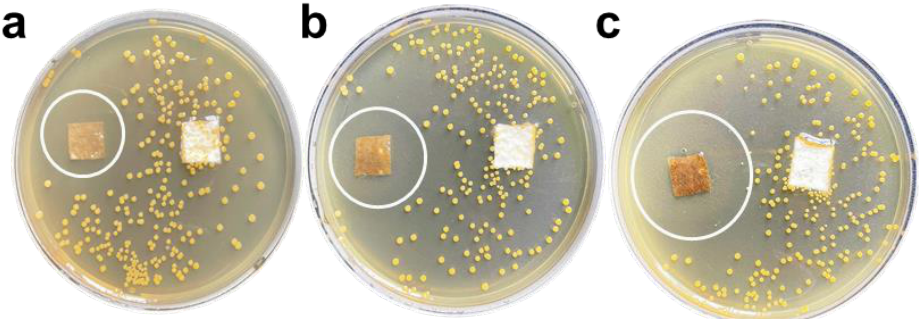
Figure 6. Antibacterial zone diagram of antibacterial coating on S. aureus , the mass fractions GZC antibacterial powder are 1% ( a ), 3% ( b ) and 5% ( c ), in sequence.